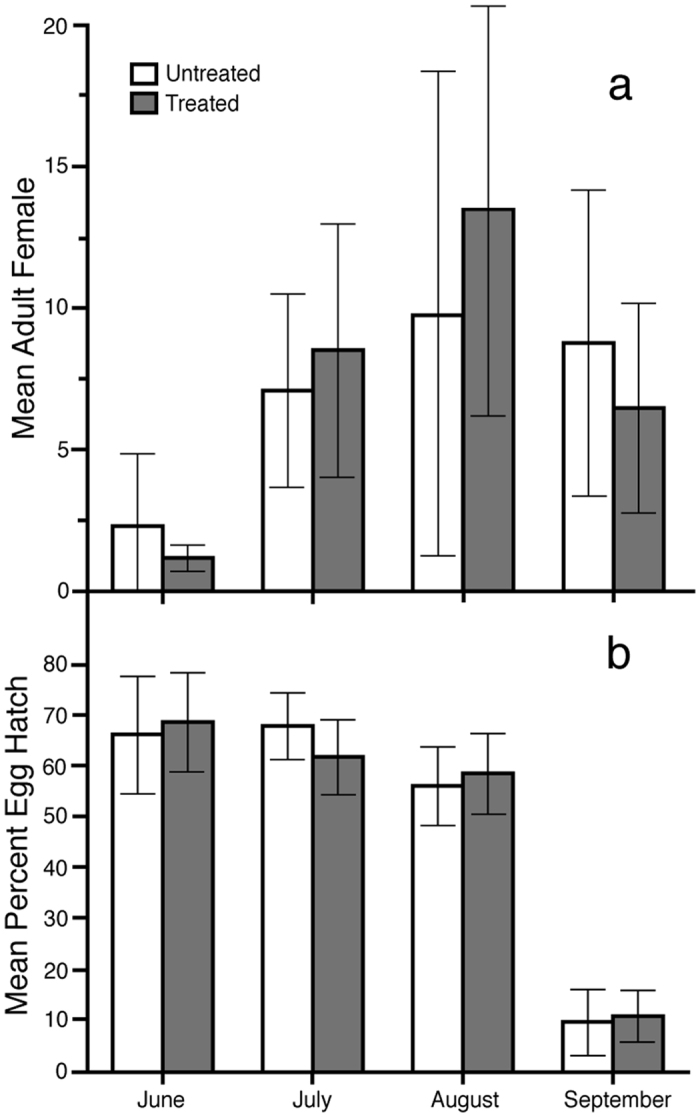
Mean (a) number of female adult Ae. albopictus collected using BG traps and (b) percent hatch of Ae. albopictus eggs collected using oviposition traps at the Treated and Untreated sites in the 2013 field season. There were no incompatible males introduced at either site in 2013. Bars show 95% confidence intervals.